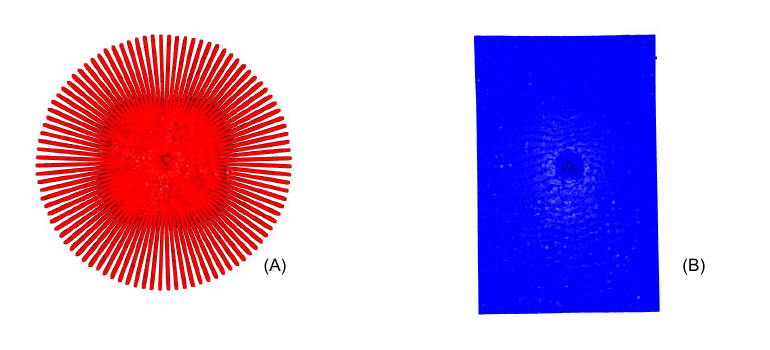
Figure 3. ( A ) presents the top view of the radial reconstructed point cloud. Note the high density of points in the area surrounding the image center. ( B ) shows the top view of the linear volumetric reconstruction point